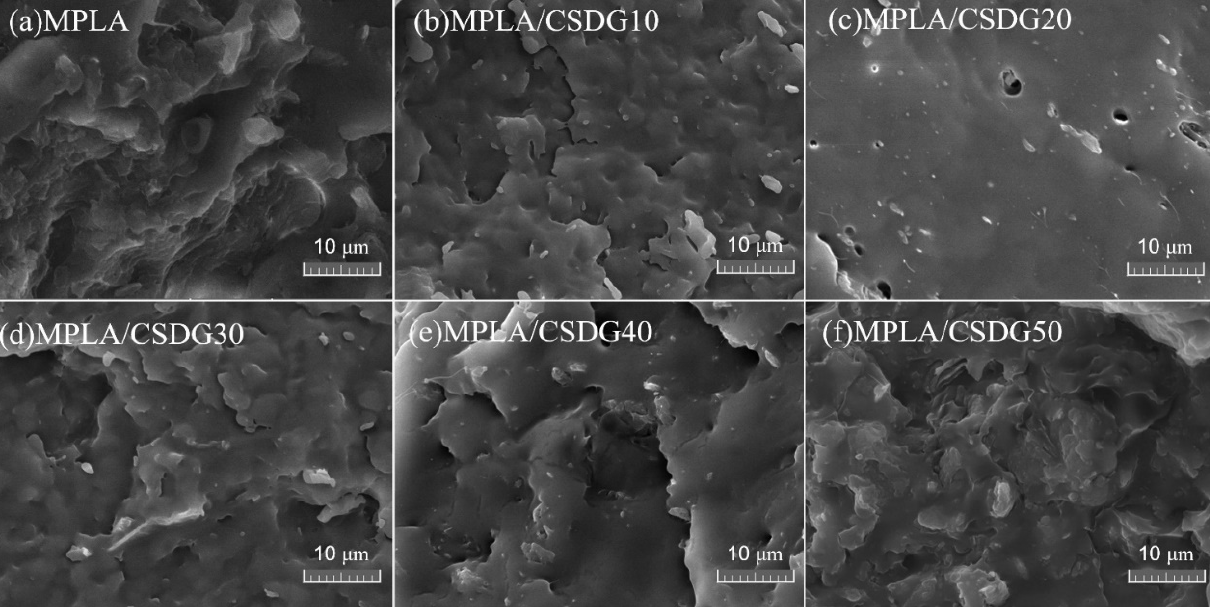
Figure 5. SEM images of MPLA and MPLA/CSDG composites: ( a ) MPLA; ( b ) MPLA/CSDG10; ( c ) MPLA/CSDG20; ( d ) MPLA/CSDG30; ( e ) MPLA/CSDG40; ( f ) MPLA/CSDG50.